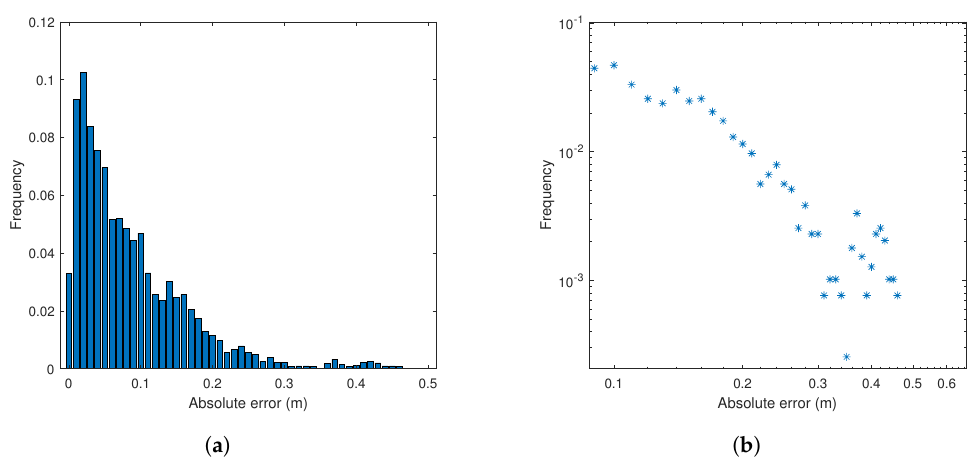
Figure 12. ( a ) Absolute error histogram for Pozyx (X-direction). ( b ) Log–log plot of absolute error histogram tail.